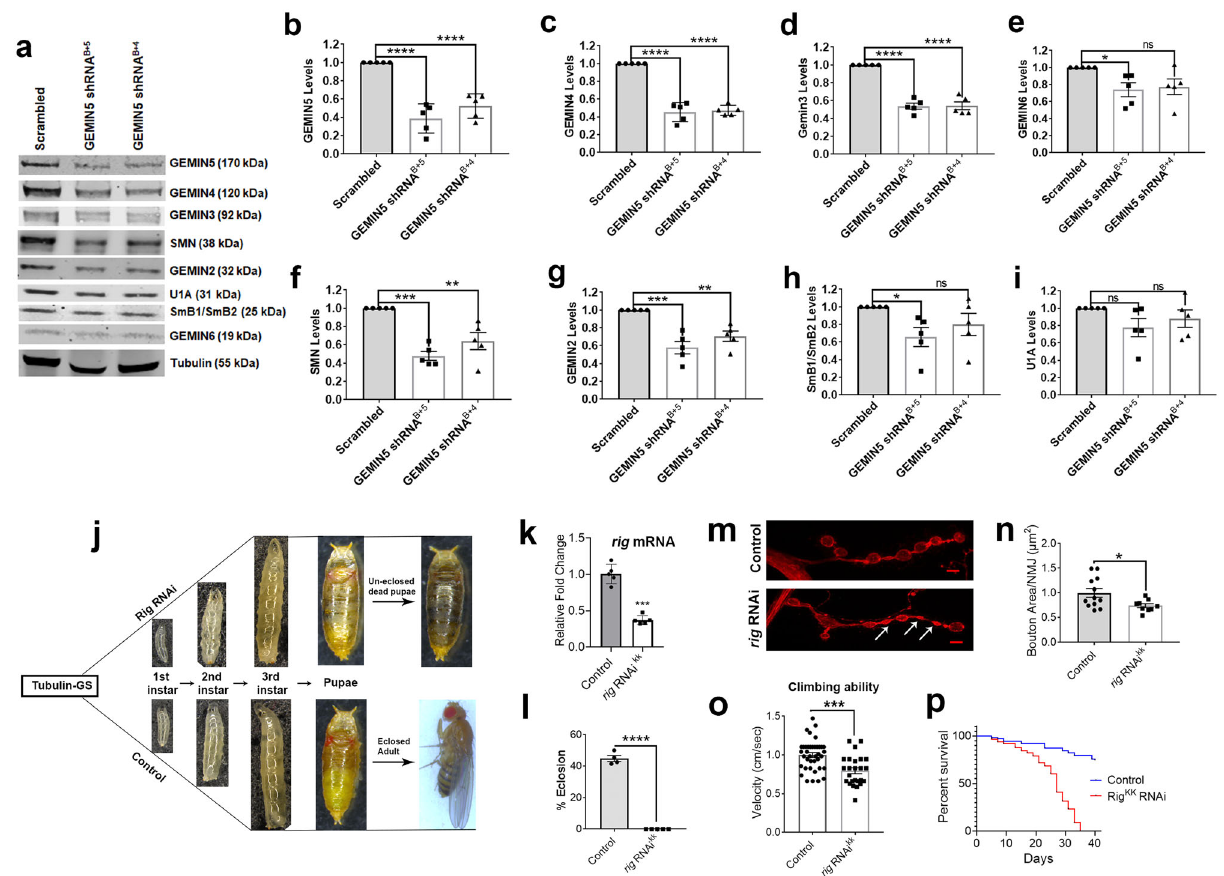
Fig. 4 Loss of GEMIN5 leads to decrease levels of snRNP complex proteins and, developmental defects and motor dysfunction in Drosophila . a Representative WB showing the effect of shRNA-mediated knockdown of GEMIN5 on the levels of GEMIN4, GEMIN3, GEMIN2, GEMIN6, SMN, SmB1/B2, and U1A as compared to scrambled control. GEMIN5 shRNA B was used in combination with GEMIN5 shRNA 5 and 4 to obtain the maximum knockdown ef fi ciency. α tubulin was used as internal control ( n = 5). b – I Quantitative analysis showed a signi fi cant decrease in the levels of GEMIN4 ( c ), GEMIN3 ( d ), GEMIN6 ( e ), SMN ( f ), GEMIN2 ( g ), and SmB1/B2 ( h ) upon ~65% knockdown of GEMIN5 ( b ). No signi fi cant change was found in U1A protein levels ( i ) (one-way ANOVA-Bonferroni test, n = 5). j Flow diagram comparing different developmental stages of fl ies between rigor mortis RNAi and W1118 control fl ies. RNAi-mediated knockdown of rigor mortis , as determined by qPCR in ( k ), resulted in pupal lethality ( j ) and eclosion defects ( l ) as measured by percentage eclosed adult homozygous fl ies (two tailed unpaired t test, n = 5). The RNAi transgene under inducible tubulin-UAS gal4 system was expressed by growing the larvae on 1 mM RU486 drug food. m Representative IF images of neuromuscular junction (NMJ) marked with HRP (pre-synaptic marker) in the larval segment expressing rig mortis RNAi compared to control (scale bar = 10 µ m). n Quantitative comparison of the bouton size measured as area per negative geotaxis (RING) assay, calculated as climbing speed of a fl y per second, showed signi fi cant defects in the climbing velocities of fl ies with RNAi-